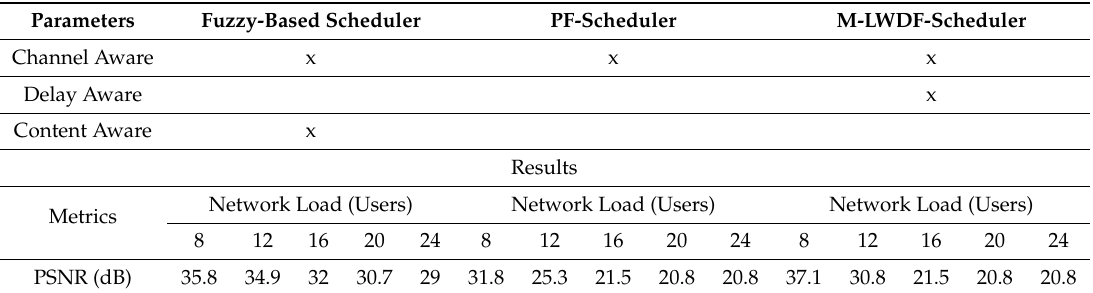
Table 2. Simulation results for content-aware and content-unaware scheduling